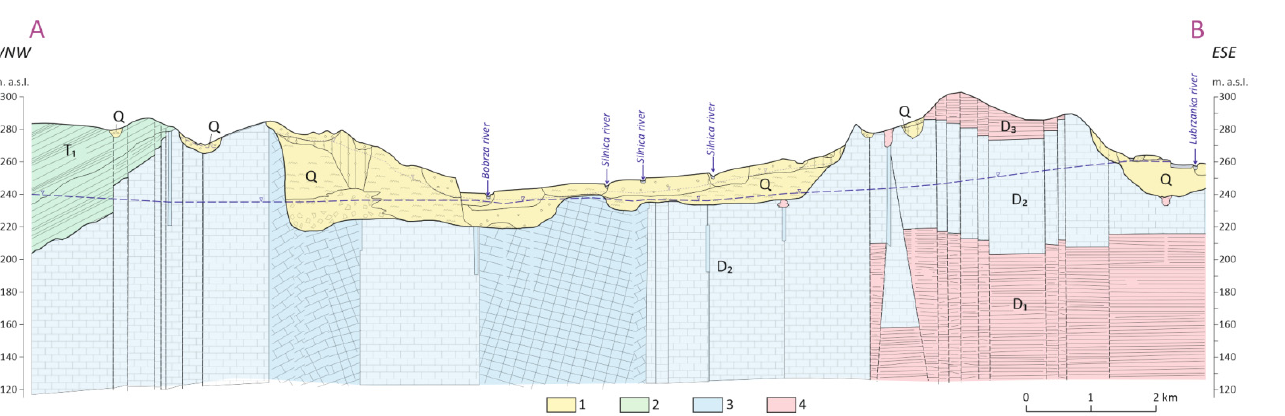
Figure 2. Geological cross-section of the modelled area of the MGWB No. 417 (according to [28]; the cross-section line is shown in Figure 5) 1—pore aquifers within Quaternary sediments (permeable and poorly permeable sediments), 2—fracture and fissure-pore aquifers, 3—karst-fissure reservoirs, 4—impermeable units.